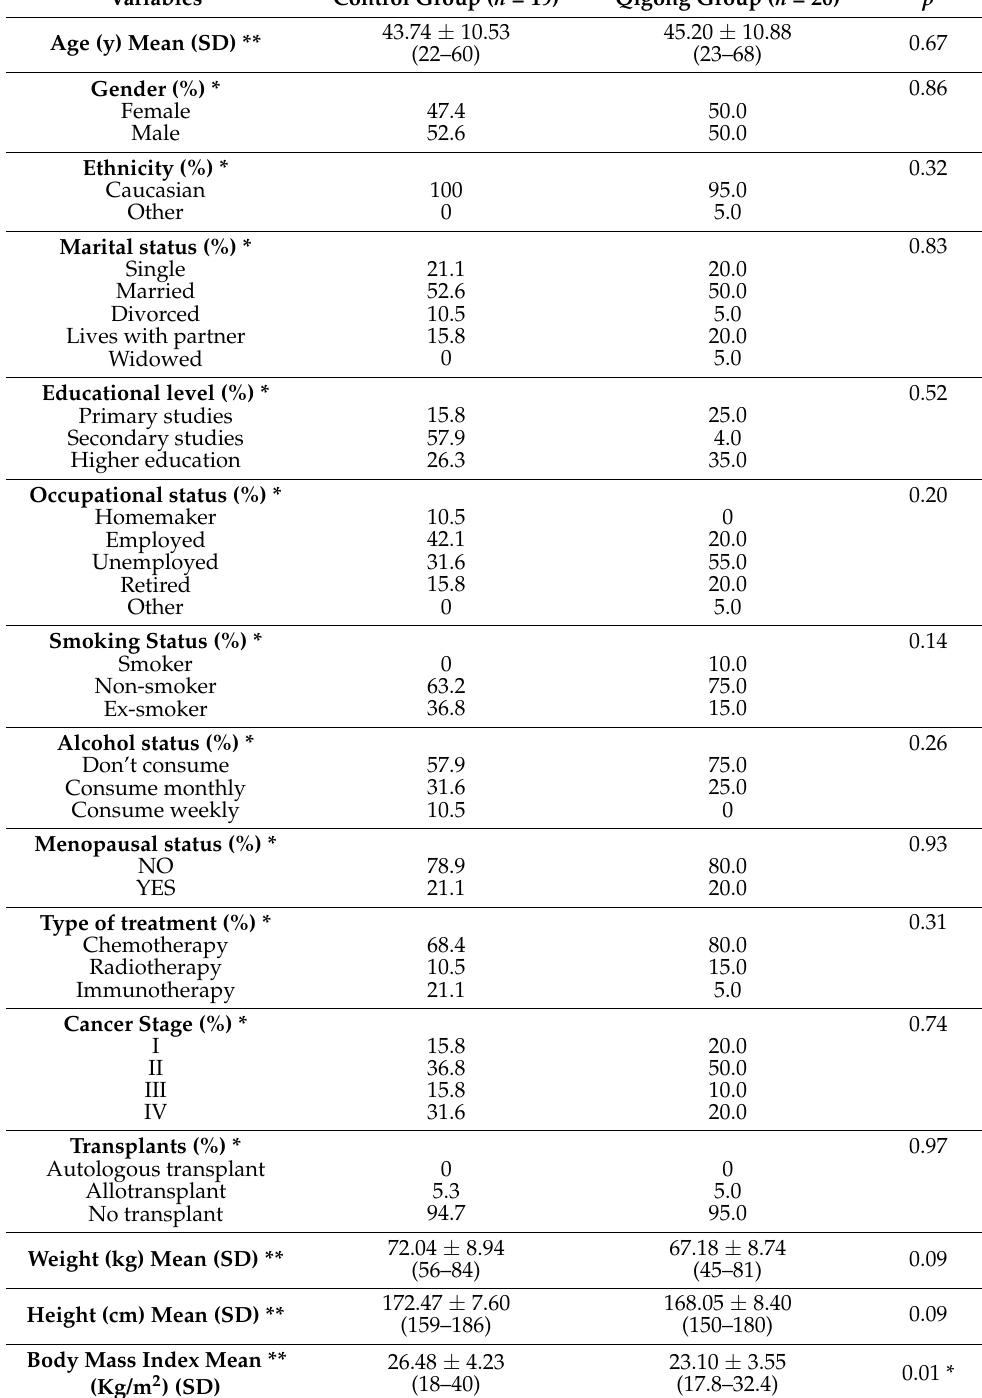
Table 1. Sample characteristics and comparison between the study